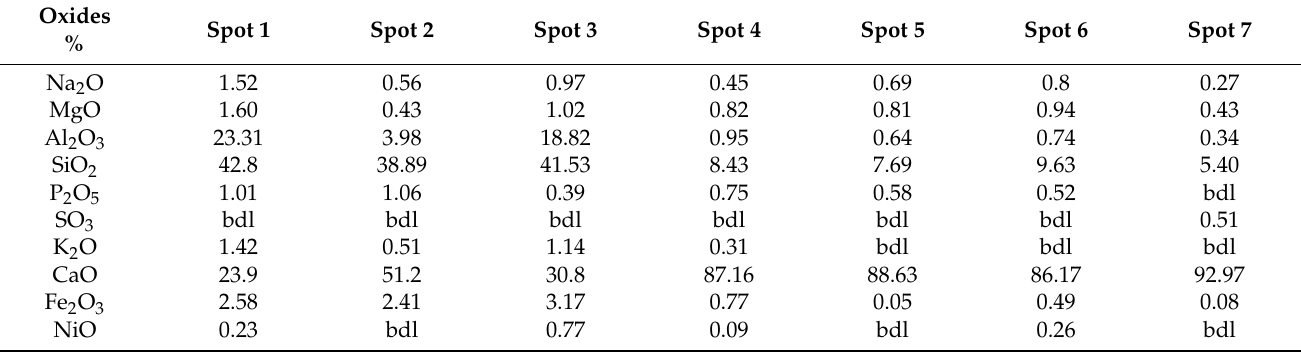
Table 9. Microchemical spot analyses of binder areas of from bedding mortar of Palazzo Davanzati